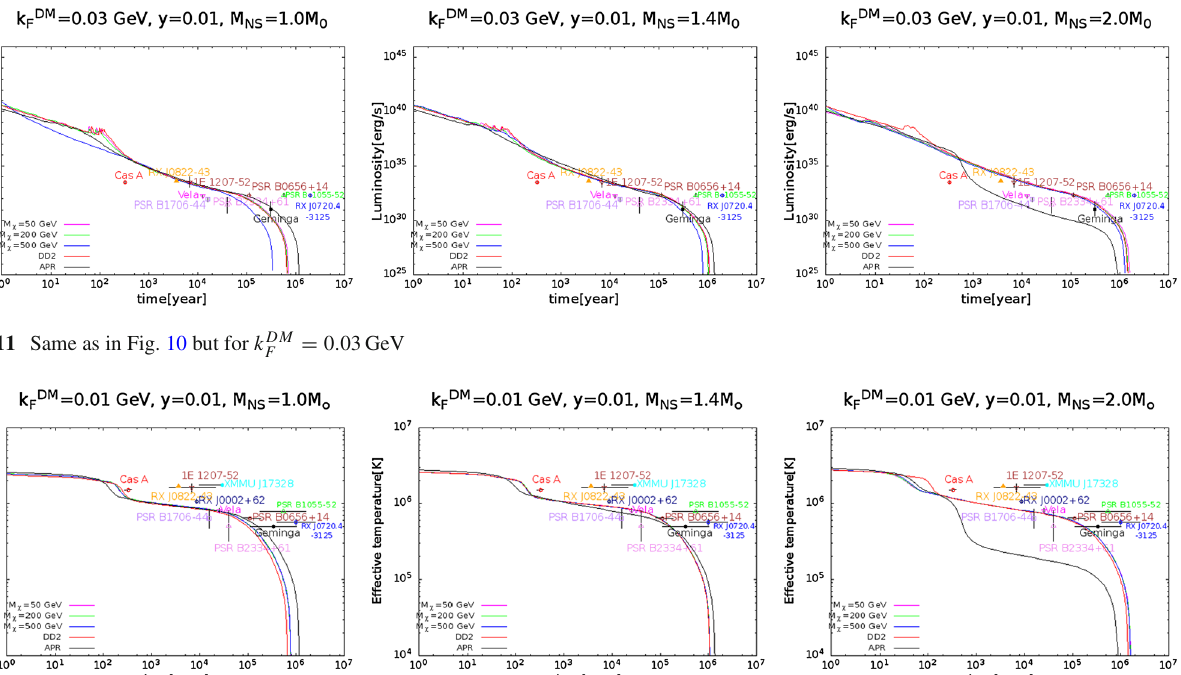
Fig. 12 Variation of tuminosity with time for chosen three differ- ent NS masses M NS = 1 . 0 M (cid:8) (left panel), M NS = 1 . 4 M (cid:8) (mid- dle panel), M NS = 2 . 0 M (cid:8) (right panel) with varying M χ and fixed = 0 . 01GeV in each panel. The theoretical calculations are com- k DM F